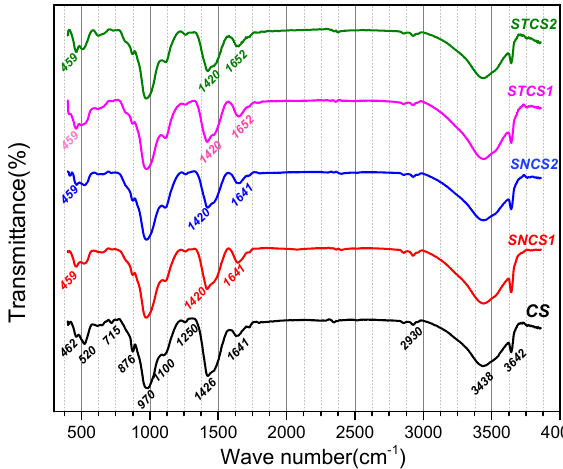
Fig. 9. FTIR spectra of the control sample (CS) and reinforced cement paste Figure 9. FTIR spectra of the control sample (CS) and reinforced cement paste samples